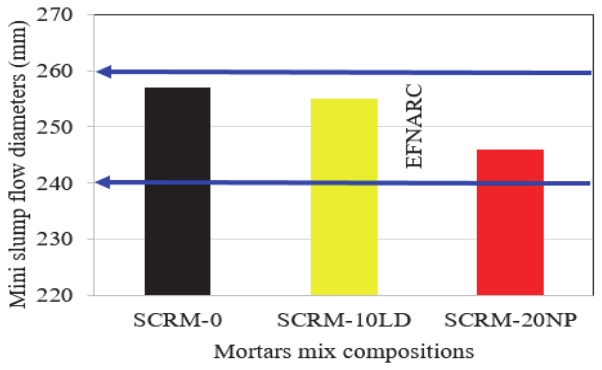
Figure 4: Mini-slump flow for